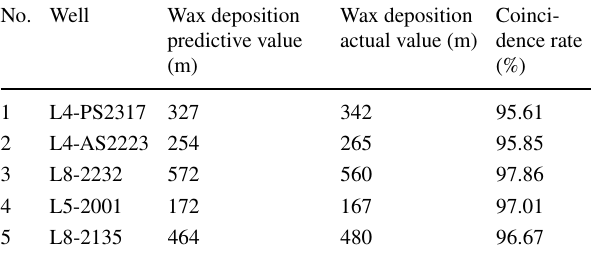
Table 1 Predictive and actual value of wax deposition location 95.61–97.86%No.